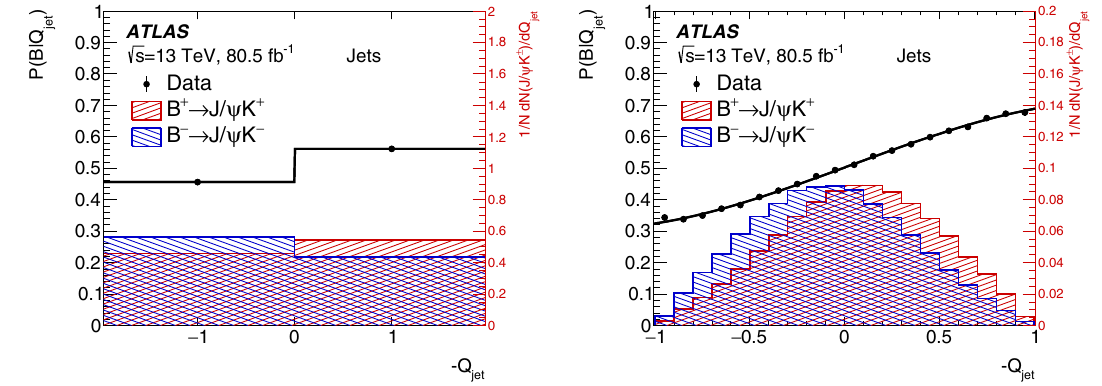
Fig. 5 Normalised cone charge distributions (shown against the right axis scale), − Q jet , for B + ( B − ) events shown in red (blue) for jets, for cases of discrete charge (left), and the continuous distribution (right). Superimposed is the distribution of the tag probability, P ( B | Q jet )